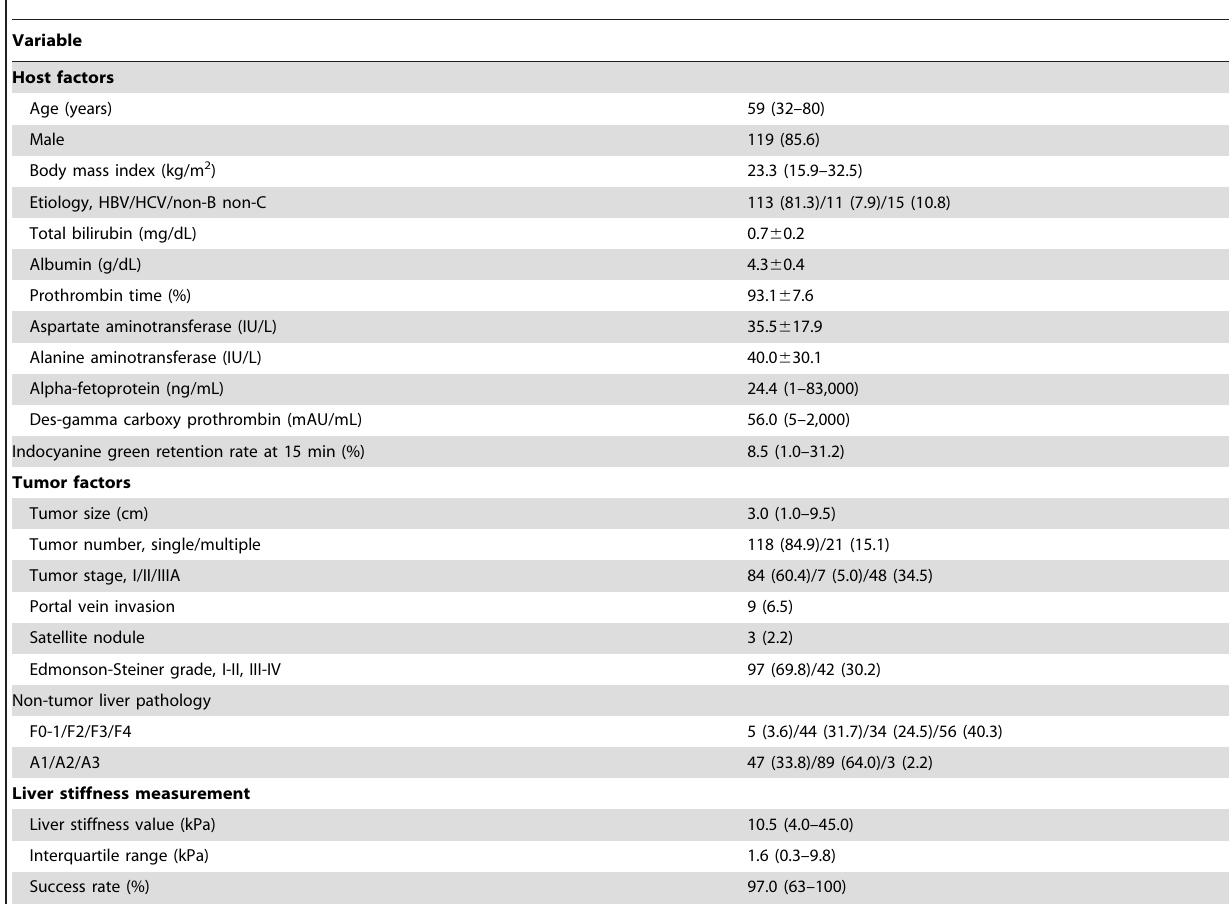
Table 1. Baseline characteristics (n